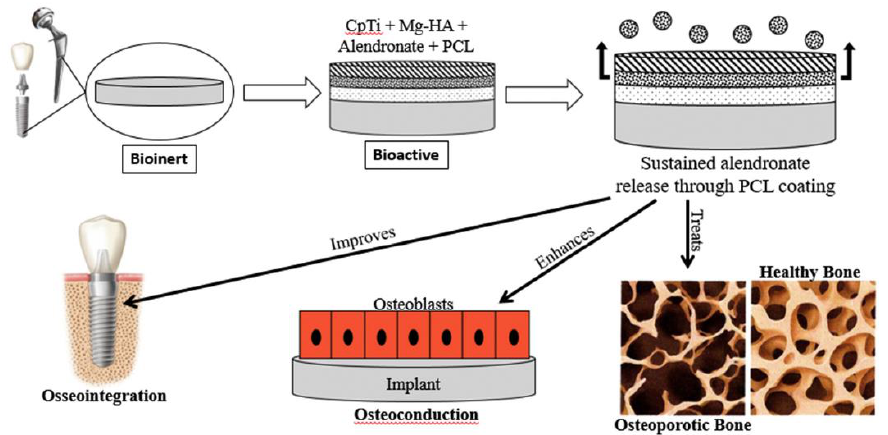
Figure 1. Hydroxyapatite (HA)-coated commercially pure titanium (CpTi) is initially bioinert, but the deposition of a Mg–HA coating and loaded with alendronate enhances bioactivity. Polycaprolactone (PCL) coating enables the sustained release of alendronate, which can be used in hips and dental implants to treat and prevent osteoporosis, enhance osteoconduction and improve osseointegration. Images: Wolgin, MD, orthopedic surgeon. The Osteoporosis Center. American Academy of Implant Dentistry. Adapted with permission from [10]. Copyright Elsevier.